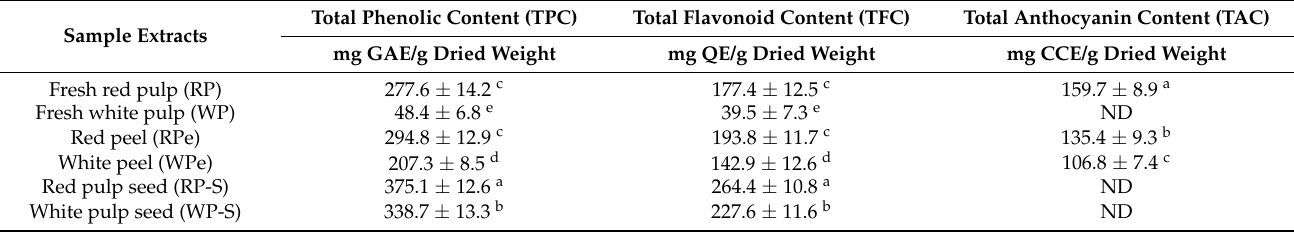
Figure 1. Red and white dragon fruits used in this study ( A ) and anthocyanin extract prepared from the red peel ( B ). Table 1. Total phenolic, flavonoid, and anthocyanin contents.